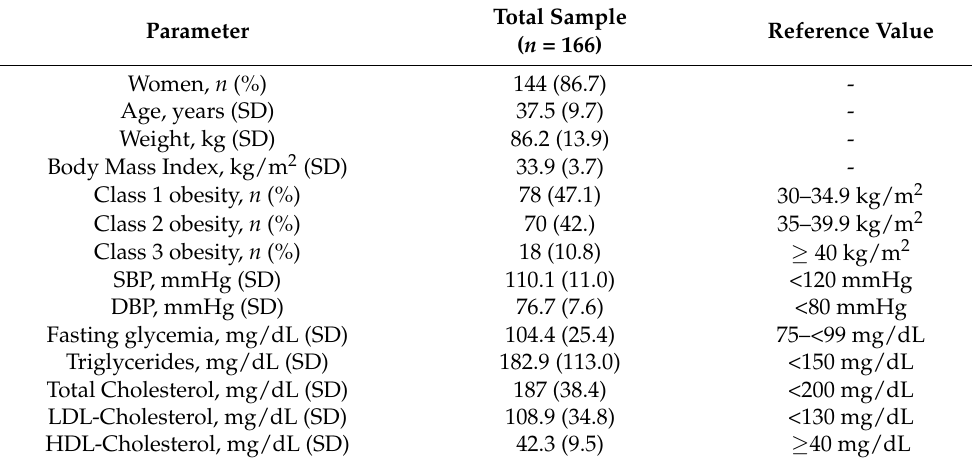
Table 1. Baseline characteristics of subjects in this